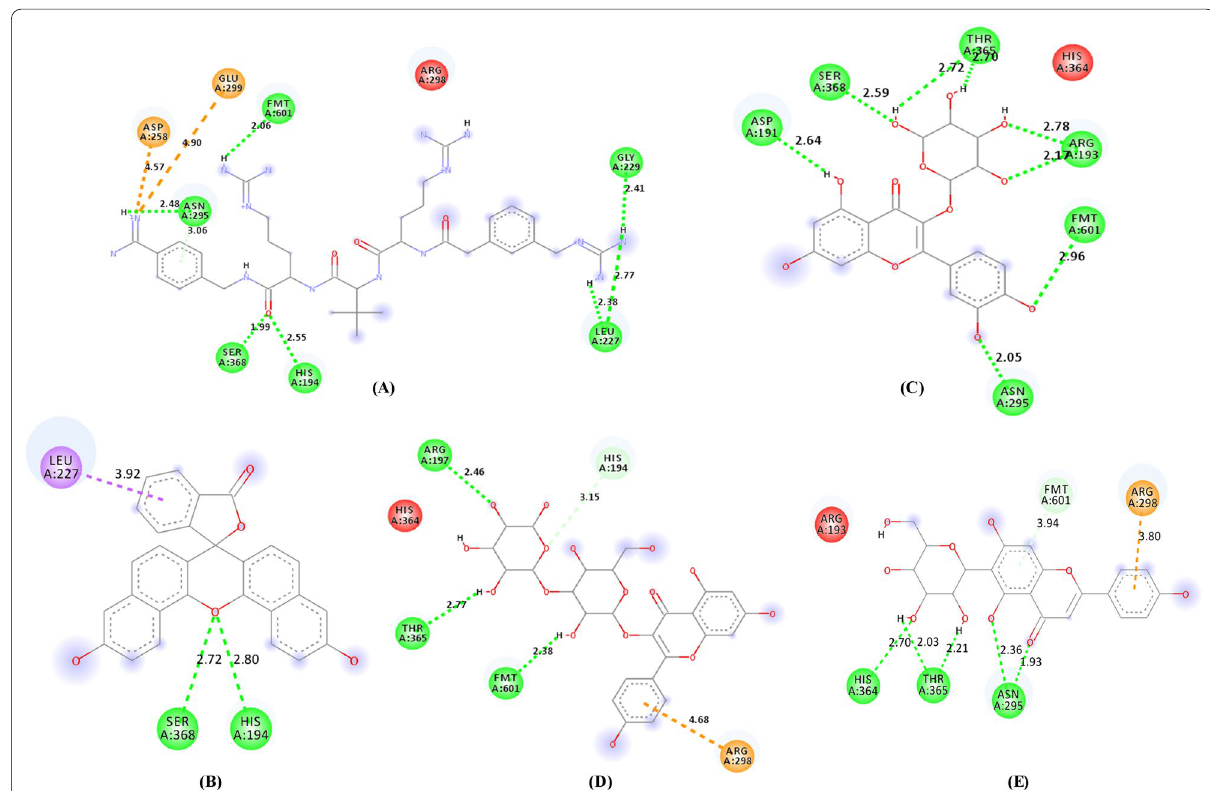
Fig. 6 Visualization of ligand interactions between the amino acid residues of the active binding pockets of furin with PGPRTRA ( a ), naphthofluorescein ( b ), C_18 ( c ), C_4 ( d ) and C_5 ( e